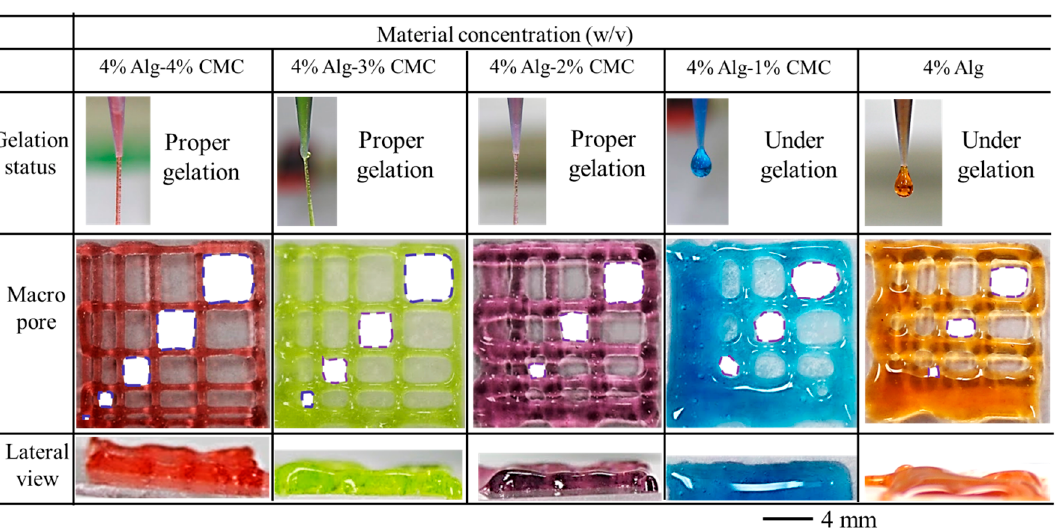
Figure 11. Diffusion rate and printability in filament fusion test. 3.4. Filament Collapse Test The qualitative observation of the collapse test for various compositions of material identifies that with increasing the percentage of CMC leads minimum deflection of the suspended filament as shown in Figure 12a. Composition with 4% Alg-4% CMC generates almost straight filament on the pillars situated at various distances. The collapse area factor for each distance value of each material composition is determined using the Equation (4). With increasing the pillar to pillar distance, the collapse area factor shows decreasing trend as shown in Figure 12b. The graph indicates the composition with 4% Alg-4% CMC has minimum collapse area factor even with increasing the distance value. Composition with 4% Alg-1% CMC is not able to hold the filament geometry and breaks away even at 4 mm distance value. The same scenario happens for 4% at 3 mm distance value. Hence, this event results in zero collapse area factors for these two compositions.